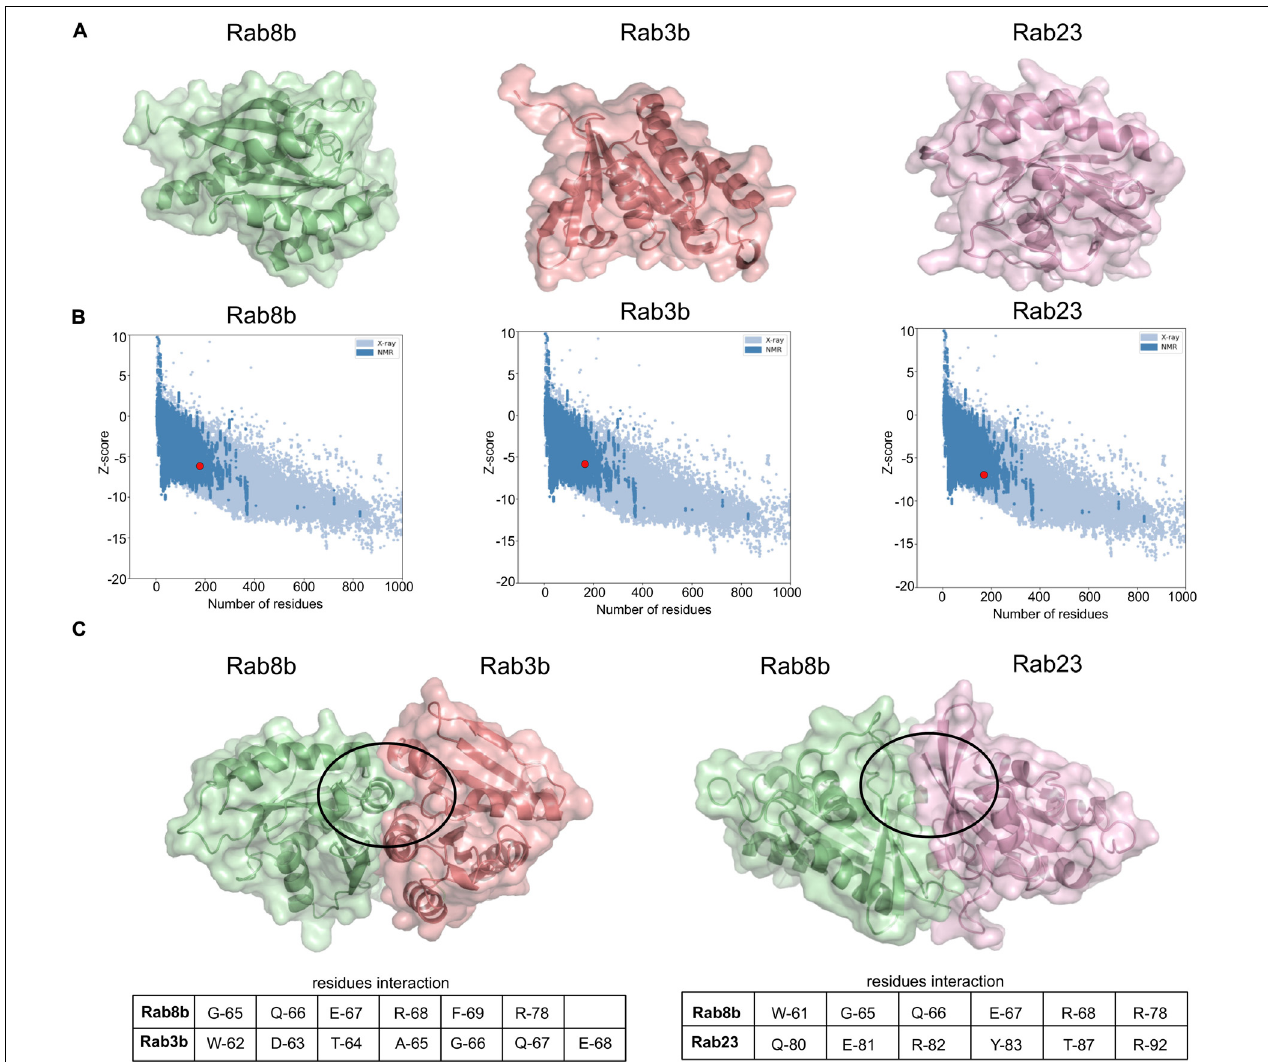
FIGURE 6 | Interaction between Rab8b and their targets. (A) The 3D models of Rab8b , Rab3b , and Rab23 modeled using SWISS-MODEL. (B) 3D models structure validation by ProSA. This plot represents modeled structure score, Rab8b ( z score: –6.11), Rab3b ( z score: –5.71), and Rab23 ( z score: –6.99) specified by the red dot, shows and that it is in the range of scores found on comparable sized proteins with an NMR quality. (C) The 3D structures Rab8b–Rab3b and Rab8b–Rab23 interactions were built on the 3D models from SWISS-MODEL and docking simulation was done using HDOCK program. The circles highlight regions of interacting residues in the protein 3D